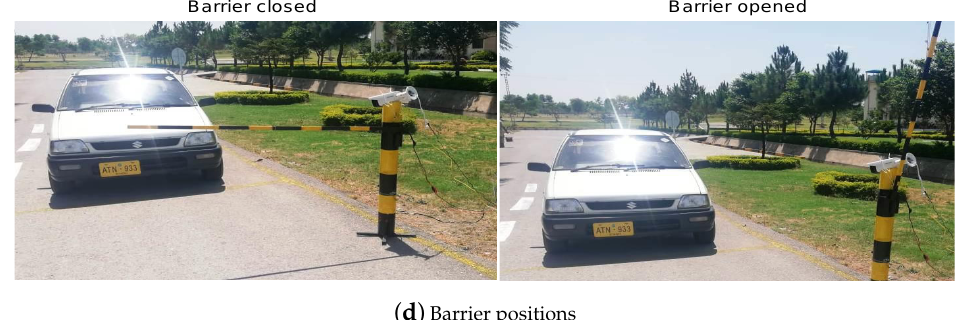
Figure 8. Hardware Setup and mechanism of barrier system control using DC